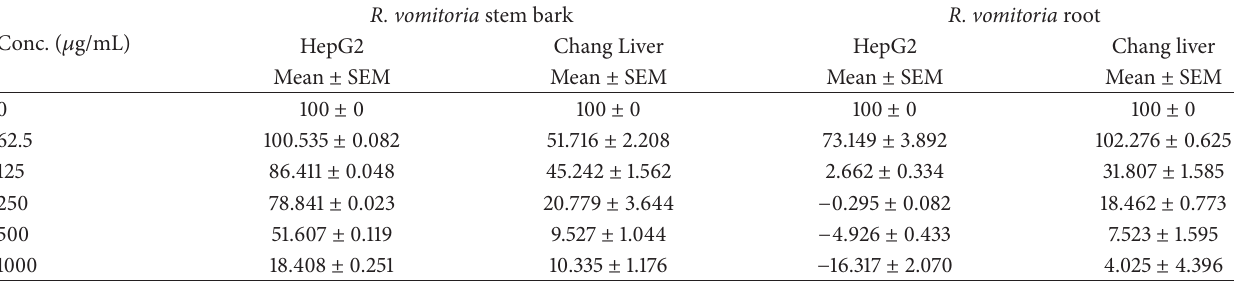
Table 3: Percentage viability of cell proliferation.